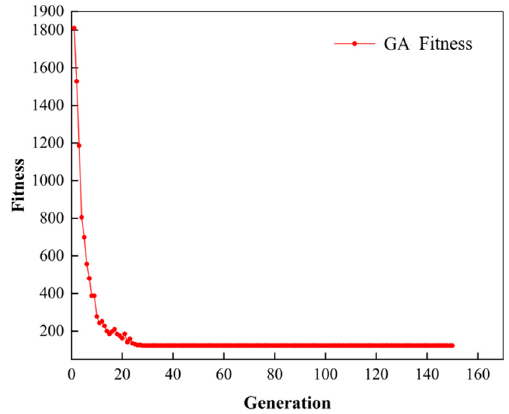
Figure 6. Training results of GA algorithm.